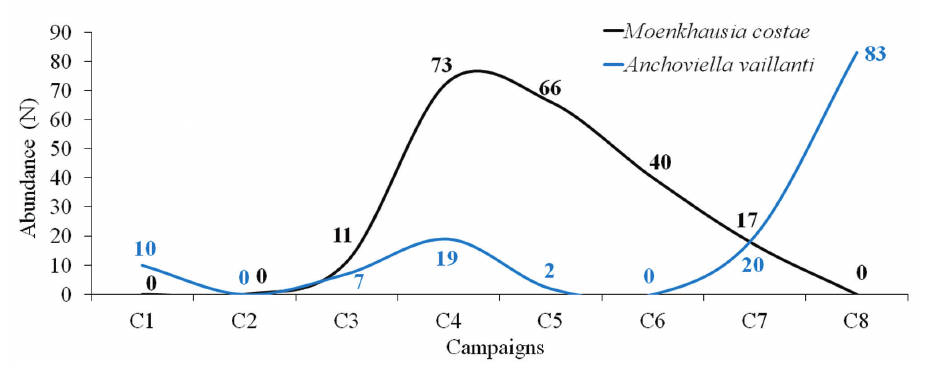
FIGURE 4 | Variation in the abundance of non-native species Anchoviella vaillanti and Moenkhausia costae in the Poções Reservoir (RB 1) in the campaigns conducted after the arrival of the SF-IWT